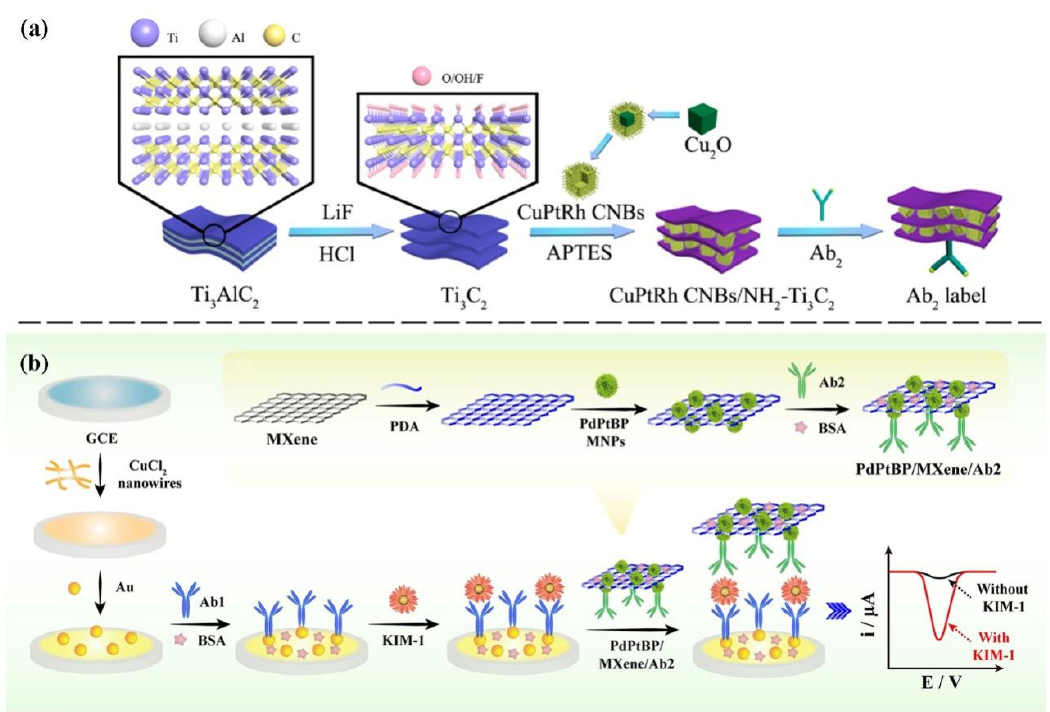
Figure 6. ( a ) The preparation steps of CuPtRh CNBs/NH 2 –Ti 3 C 2 based Ab 2 label for cTnI detection. Reprinted with permission from Ref. [61]. 2020, American Chemical Society. ( b ) The fabrication steps of sandwich-type electrochemical immunosensor for detection of KIM-1. Reprinted with permission from Ref. [63]. 2021, Elsevier.